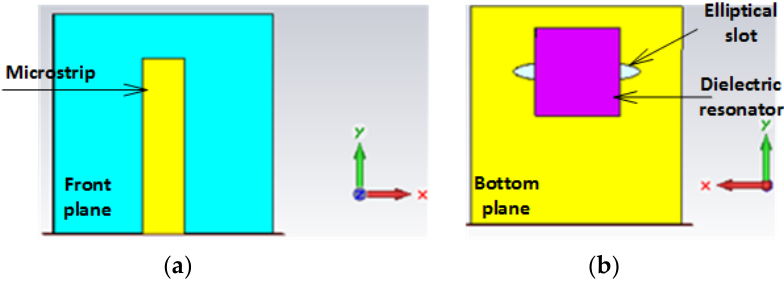
Figure 7. The modeled single resonating element: ( a ) Front plane; ( b ) Bottom plane.